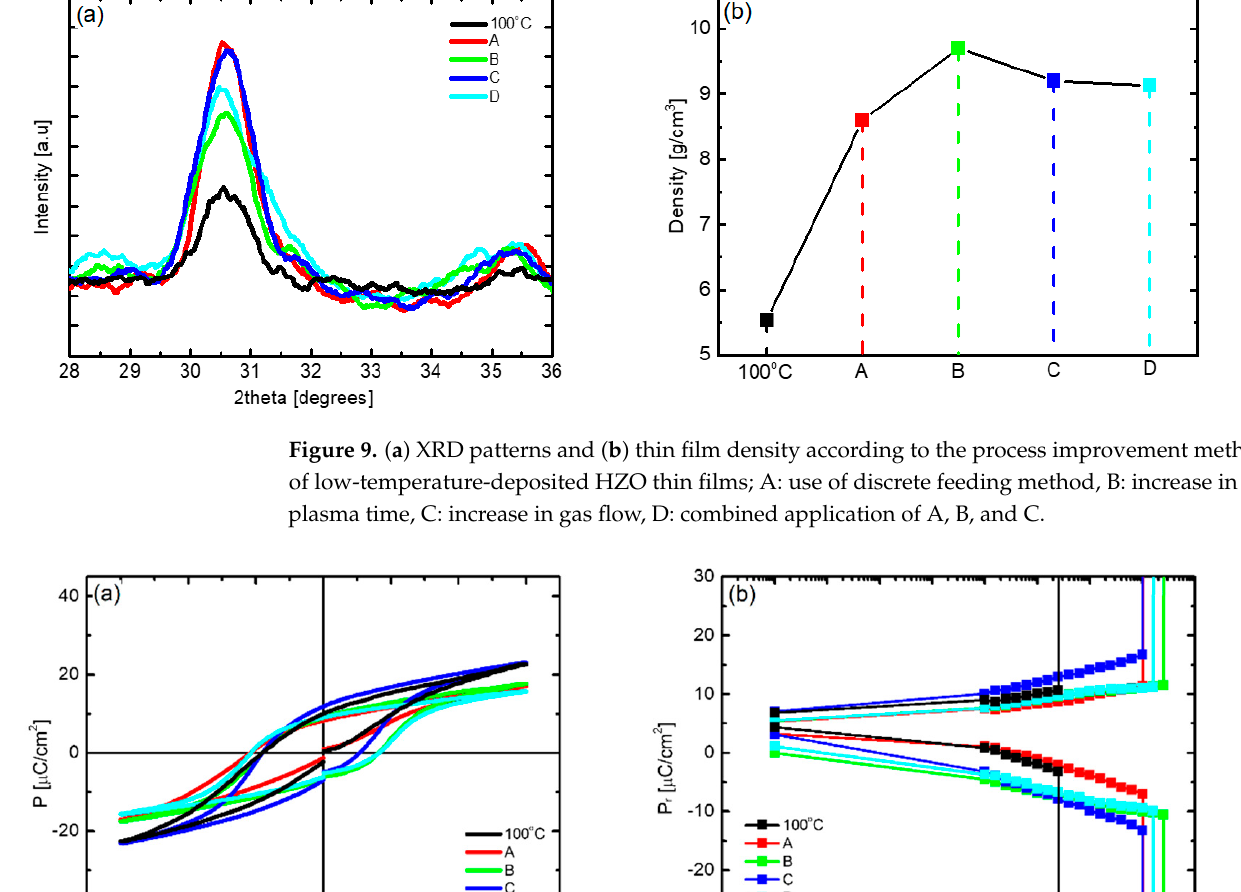
Figure 10. ( a ) P − E hysteresis curves and ( b ) fatigue endurance characteristics according to the pro- cess improvement method of low − temperature − deposited HZO thin films; A: use of discrete feeding method, B: increase in RF plasma time, C: increase in gas flow, D: combined application of A, B, and C.